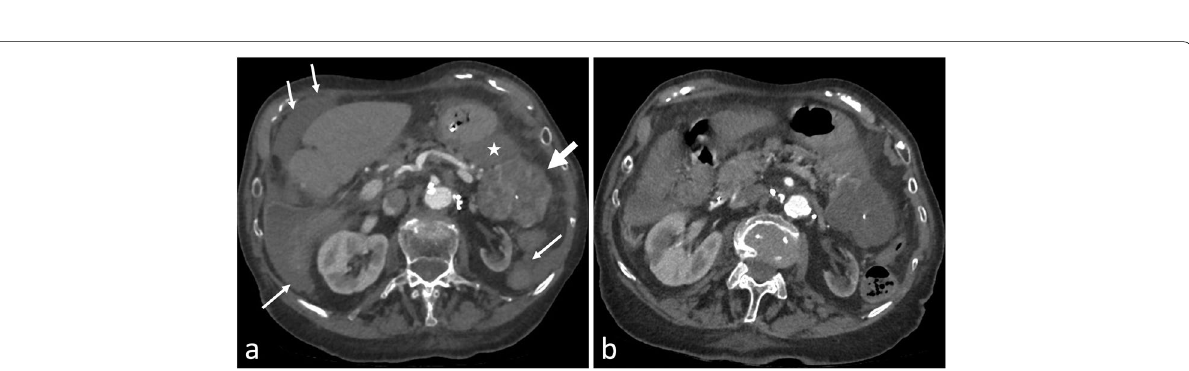
Fig. 2 Axial CT‑scan images, at the late arterial phase, before ( a ) and after ( b ) embolization procedure. a Initial CT‑scan revealed a hematoma (star) next to the pancreatic tumor (thick arrow) and diffuse hemoperitoneum (thin arrows). Note the hypervascularisation of the tumor septa and the central calcification, both characteristic of serous cystadenoma. The lesion doubled in size in thirteen years (66 mm vs 31 mm). b CT‑scan 2 days after embolization confirmed the disappearance of the hypervascularization of the tumor, with no signs of further bleeding